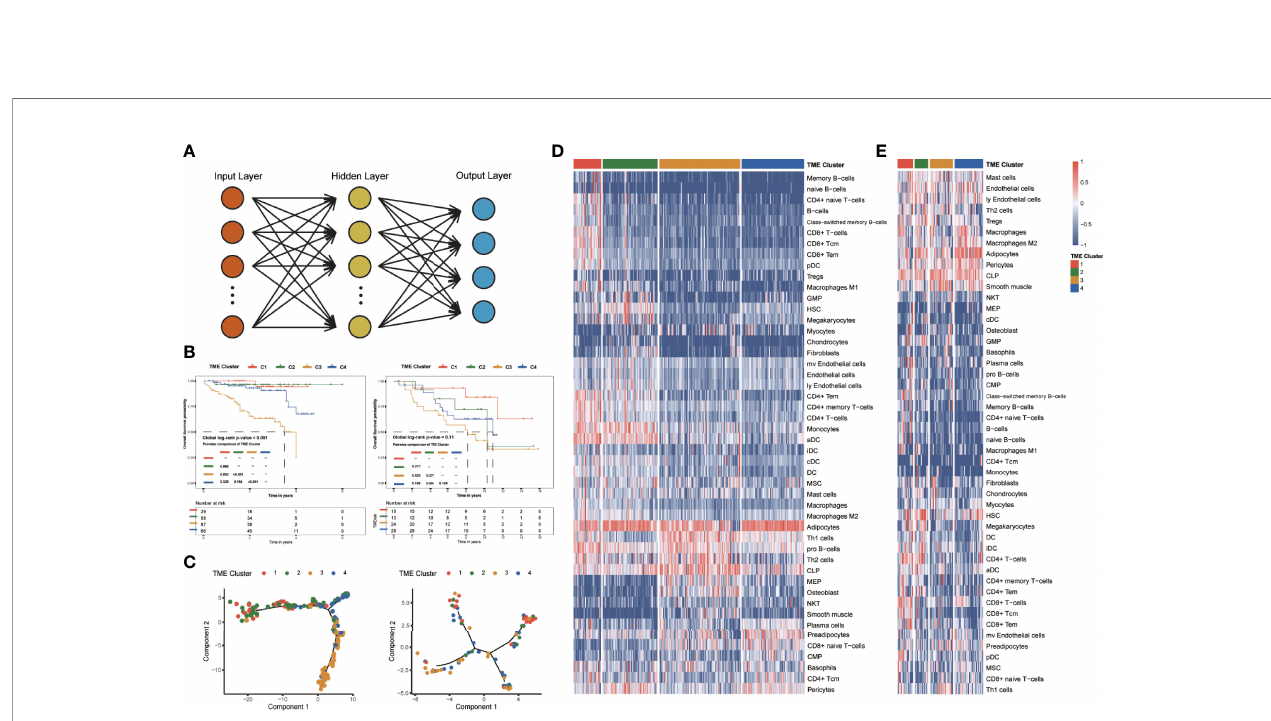
FIGURE 6 | Identi fi cation and clinical characteristics of TME clusters in the veri fi cation group. (A) Neural network. The cell matrix was the input layer, and the subtype result was the output layer. (B) Kaplan – Meier curves for overall survival of 240 patients in the Japanese cohort (global log-rank test, p < 0.0001), and 80 patients in the Hoshida Y et al. cohort (global log-rank test, p = 0.11). (C) Pseudotime trajectory analysis of the Japanese cohort and the Hoshida Y et al. cohort. (D) Unsupervised clustering of TME cells for 240 patients in the Japanese cohort. (E) Unsupervised clustering of TME cells for 80 patients in the Hoshida Y et al.